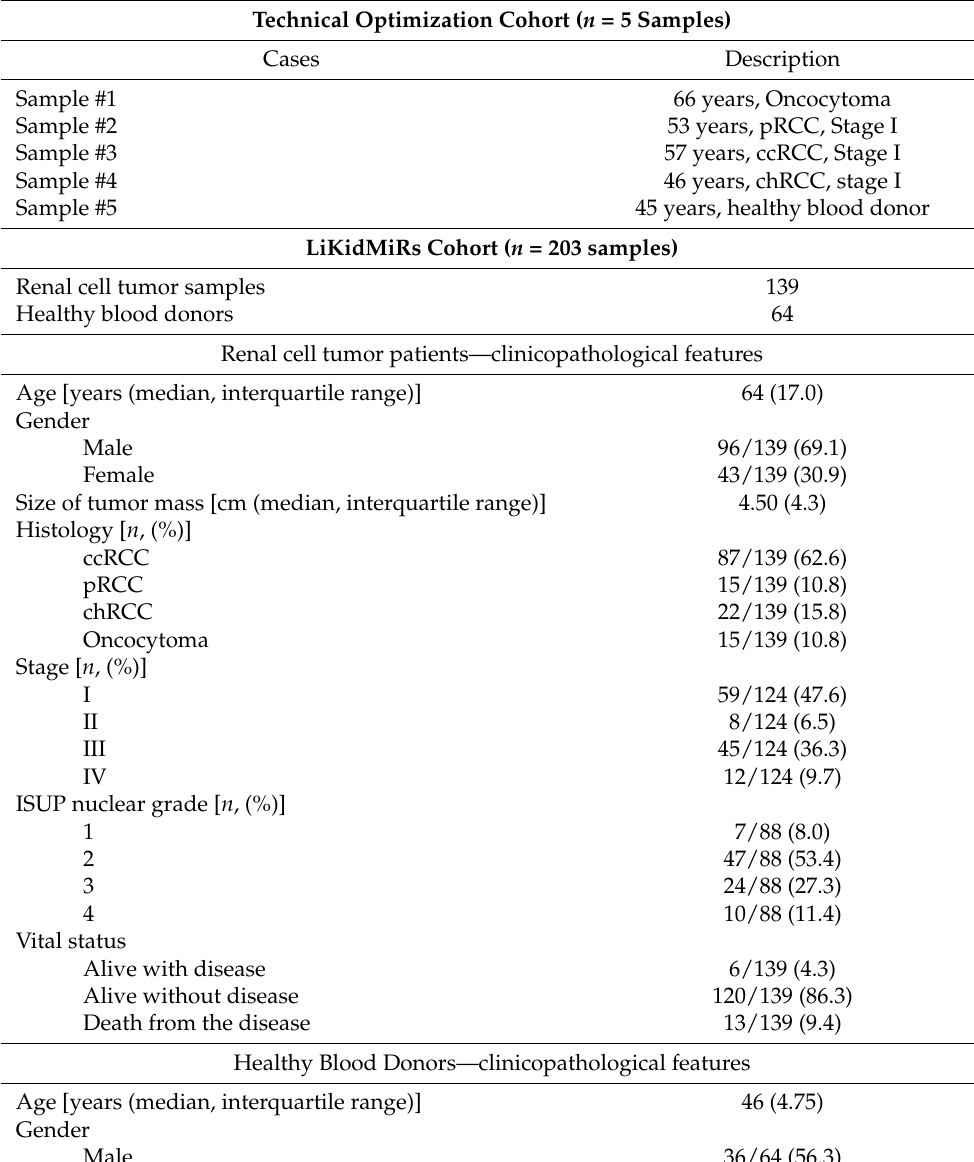
Table 1. Clinicopathological data of the technical optimization cohort (5 samples) and LiKidMiRs cohort (composed of 139 Renal Cell Tumors and 64 Healthy donors’ samples) used in this